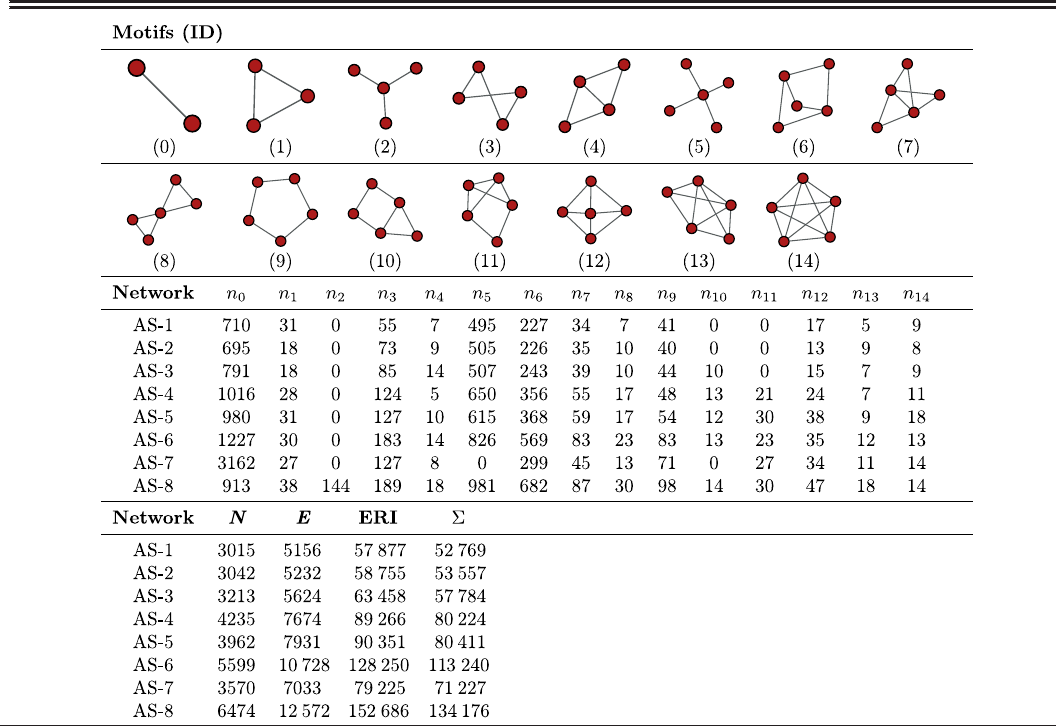
TABLE VI. The motifs of various autonomous system networks obtained using all connected motifs up to size